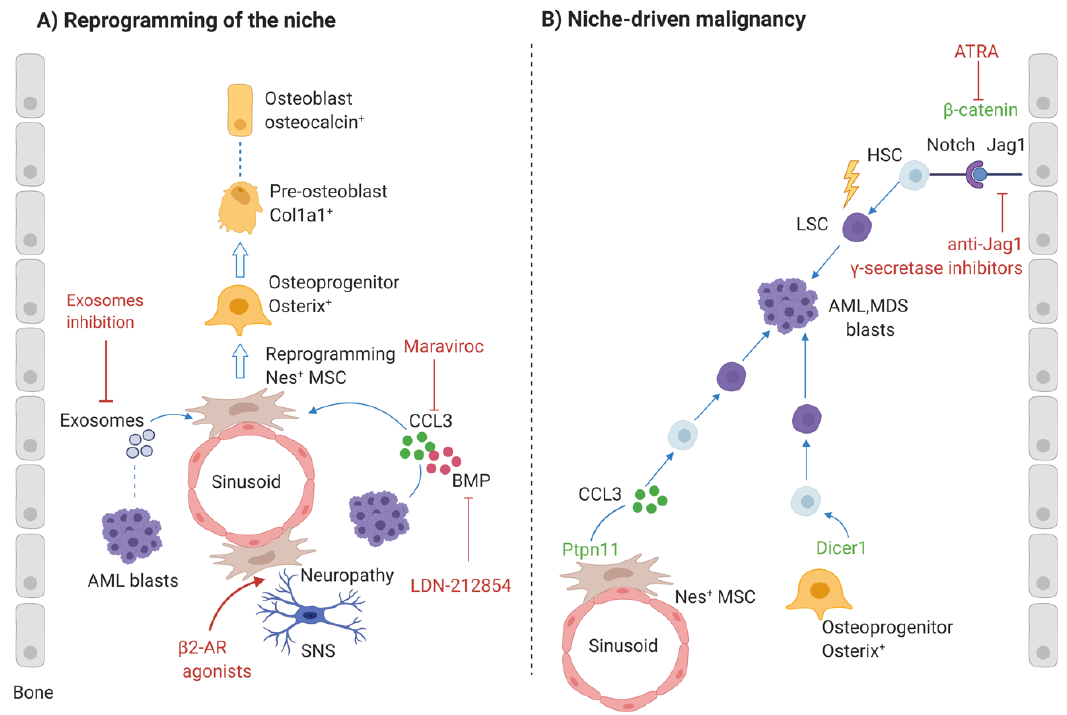
Figure 3. Osteogenic niche in leukemogenesis. ( A ) Leukemic cells reprogram BM niche into a self-reinforcing leukemic microenvironment. AML blasts induce osteogenic differentiation in MSCs through cell-to-cell contact and secretion of chemokine ligand 3 (CCL3) and bone morphogenetic proteins (BMP). Reduction of the sympathetic nervous system promotes the expansion of osteoblastic-primed MSCs, which can contribute to AML progression. Exosomes containing microRNAs (miRNAs) are secreted and uptaken by MSCs, impairing HSC function and favoring the proliferation of dysplastic cells. ( B ) Mutations in niche components have been associated with the initiation of myeloid malignancies. An activating mutation of β -catenin in osteoblasts induces AML in mice through upregulation of Jagged-1 expression. As a result, Notch1 signaling is activated in HSCs. A mutation in Dicer1 in Osterix+-osteoprogenitors deregulates HSCs that become dysplastic and eventually transform to AML. An activating mutation of the protein tyrosine phosphatase SHP2 (encoded by Ptpn11) in Nestin (Nes) + MSCs leads to increased risk of leukemic transformation of HSCs via overproduction of CCL3. Potential therapeutic approaches targeting the MSCs remodeling and mutations are at pre-clinical stages (red). HSC: hematopoietic stem cell; LSC: leukemic stem cell; MSC: mesenchymal stromal cell; BMP: bone morphogenetic proteins; CCL3: C-C motif chemokine ligand 3; SNS: sympathetic nervous system; β2 -AR: β2 -adrenergic receptors; MDS: myelodysplastic syndrome; JAG1: Jagged1; ATRA: all-trans-retinoic acid. This figure has been created with Biorender.com. In vitro experiments identified differentiating OBs as potent protectors of AML cells from various apoptosis-inducing agents, such as SDF-1 and standard chemotherapeutics Daunorubicin and Ara-C [158 – 160]. However, the mechanism(s) by which OBs induced chemoresistance of AML